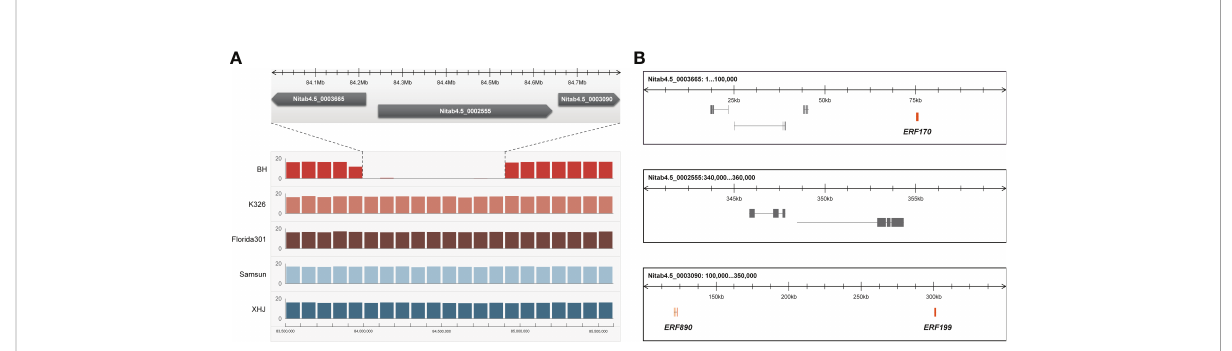
FIGURE 4 Candidate gene analysis. (A) Resequencing data of 5 tobacco accessions (BH, K326, Florida301, Samsun, XHJ) revealed a fragment deletion in BH. X-axis represent position of Chr07 with the window size of 100kb. Y-axis represent average coverage depth of resequencing data. The